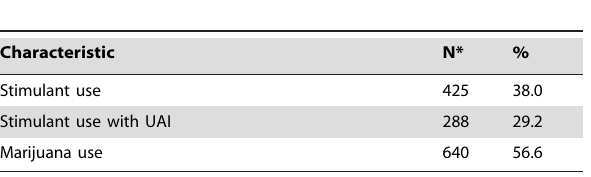
Table 1. Demographic characteristics and baseline